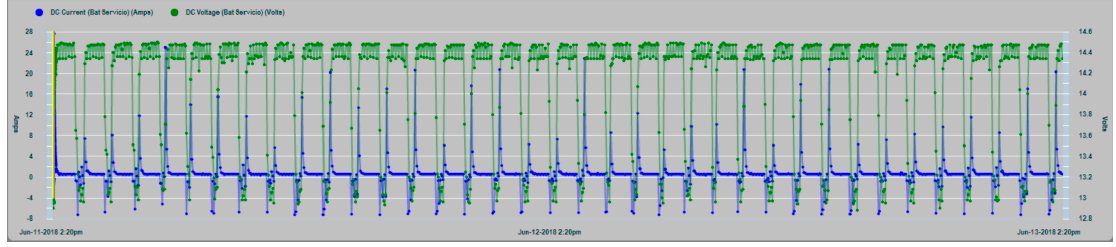
Figure 18. House battery bank charge cycling: DC current (blue), DC voltage (green).